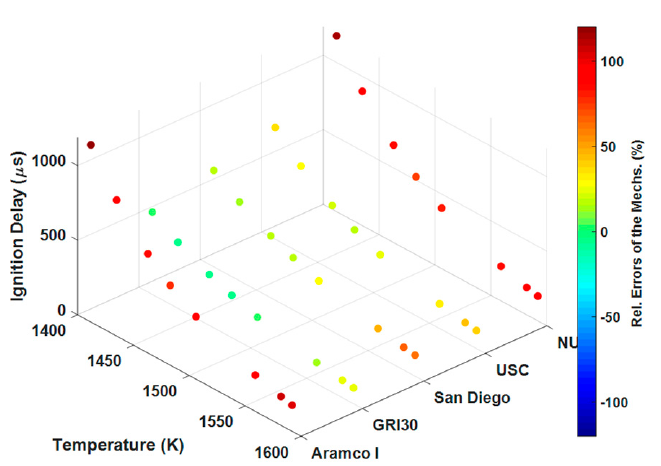
Figure 3. The relative error of simulation from experiments for methane ignition delay time ( p = 40 bar, φ = 0.5).